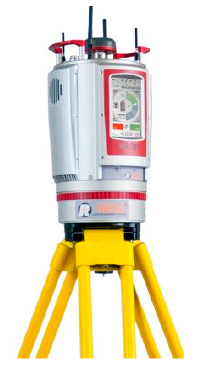
Figure 2. RIEGL VZ-1000 LiDAR scanner.